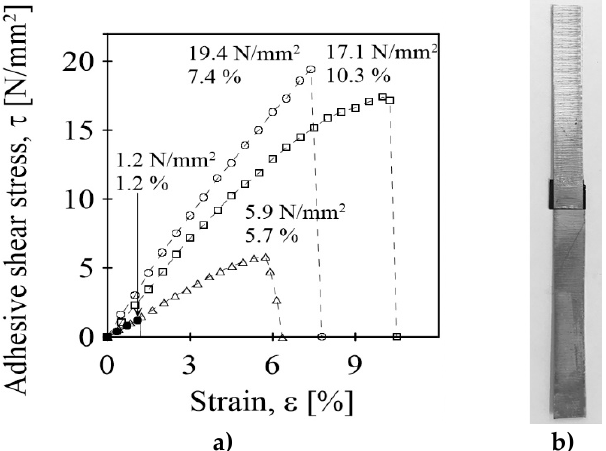
Figure 8. ( a ) The shear stress-strain relations for the bonded steel strips using the MWCNT nanopaper / epoxy composite (circles) and the epoxy adhesive (squares), and for the reheated adhesive bonding by the MWCNT nanopaper / epoxy composite at temperature of 55 ◦ C (triangles) and 72 ◦ C (filled circles). The respective ultimate stress and ultimate strain values are included in the figure. ( b ) The overlapped strips bonded by the MWCNT nanopaper / epoxy composite.